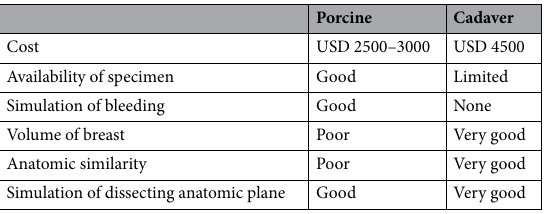
Table 4. Comparative features of porcine and cadaveric skill